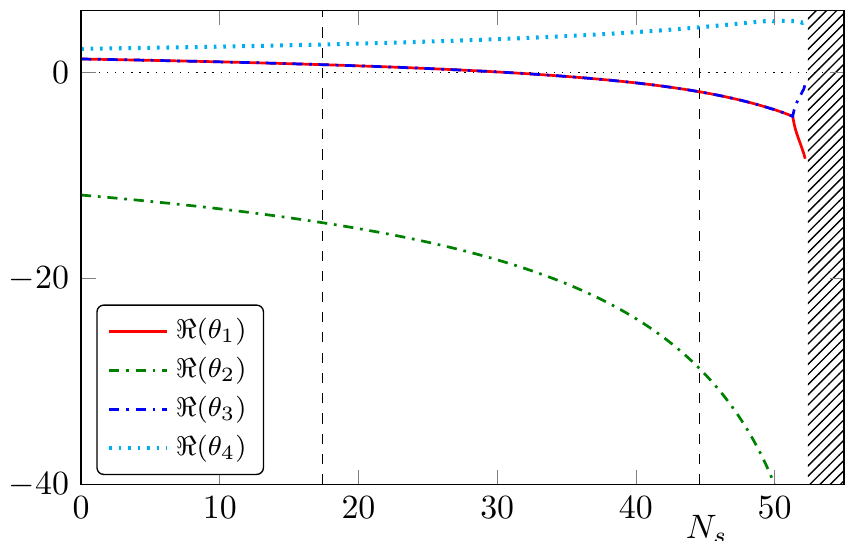
Figure 5: Critical exponents of the UV fixed point as a function of N fixed-point values. The colours of the critical exponents indicate with which coupling the corresponding eigenvector has the largest overlap. The vertical lines at N